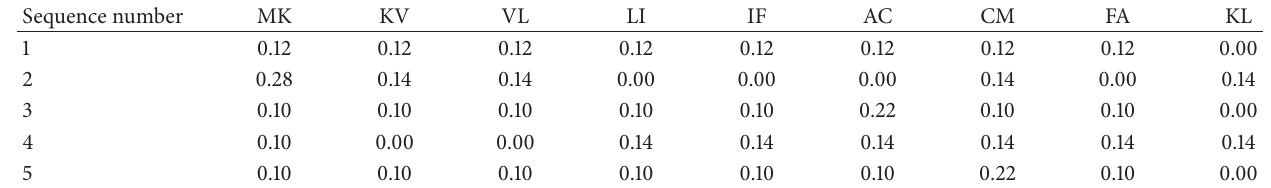
Table 2: The frequency of 𝑋 2 (two letter amino acids descriptors) for each sequence. Sequence